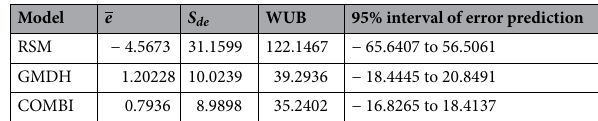
Table 9. Uncertainty analysis results for viscosity predictive models.